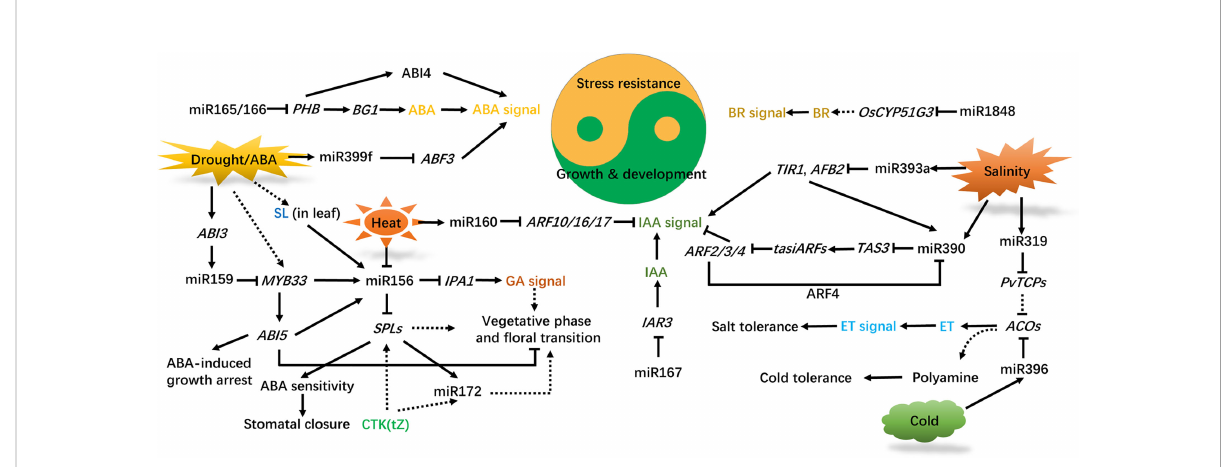
FIGURE 2 Interconnection of phytohormones and miRNAs in regulating plant development and abiotic stress responses. ABA synthesis is repressed by miR165/166, IAA accumulation is affected by miR167, BR synthesis is regulated by miR1848, and the ET content is in fl uenced by miR319/396. Drought, heat, cold, and salinity affect plant growth, development, and stress adaption by regulating hormone signal transduction mediated by miRNAs. ABA, IAA, GA, CTK, ET, BR, SL are implicated in these processes. Solid and dashed lines indicate direct and indirect regulation, respectively, and arrows and blunted lines indicate facilitation and inhibition, respectively. ABA, abscisic acid; IAA, indole acetic acid; GA, gibberellic acid; CTK, cytokinin; ET, ethylene; BR, brassinosteroid; SL, strigolactone; PHB , PHBULOSA ; BG1 , b -GLUCOSIDASE 1 ; ABI3/4/5 , ABSCISIC ACID INSENSITIVE 3/4/5 ; ABF3 , ABA-RESPONSIVE ELEMENT-BINDING TRANSCRIPTION FACTOR3 ; MYB33 , MYOBLASTOSIS33 ; SPLs , SQUAMOSA PROMOTER BINDING-LIKEs ; IPA1 , IDEAL PLANT ARCHITECTURE1 ; TIR1 , TRANSPORT INHIBITOR RESISTANT1 ; AFB2 , AUXIN SIGNALING F-BOX ; TAS3 , TRANS-ACTING-SIRNA3 ; ARF4 , AUXIN RESPONSE TRANSCRIPTION FACTOR4 ; IAR3 , IAA-ALA RESISTANT3; PvTCPs , TEOSINTE BRANCHED1/CYCLOIDEA/PCFs in Panicum virgatum L.; ACOs , 1-AMINOCYCLOPROPANE-1-CARBOXYLIC ACID OXIDASES